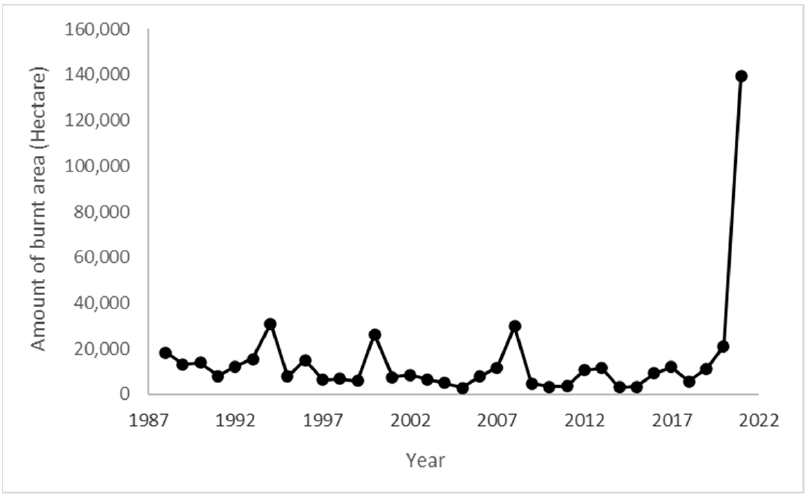
Figure 1. The amount of burned area in Turkey (1988–2021).